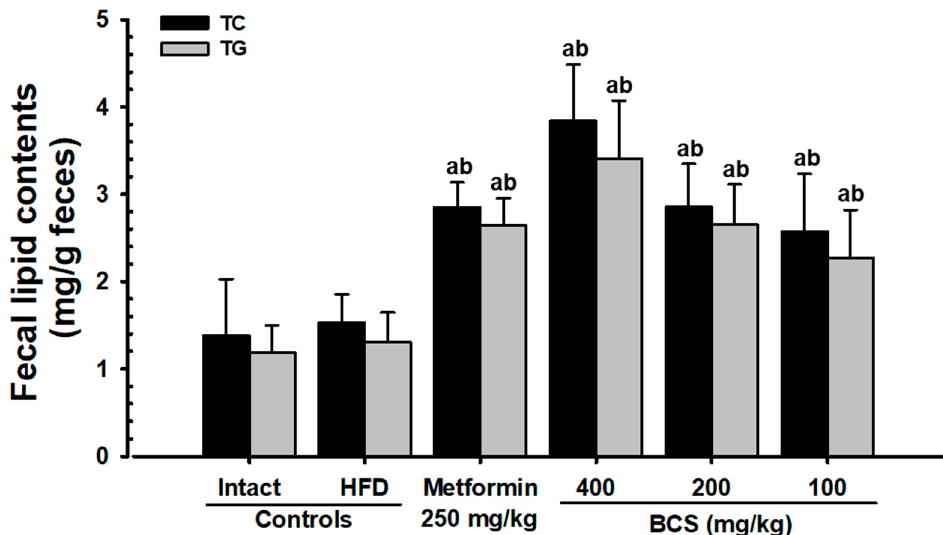
Figure 2. Fecal TC and TG content in NFD- or HFD-supplied groups. DT3: Dunnett’s T3 test; THSD: